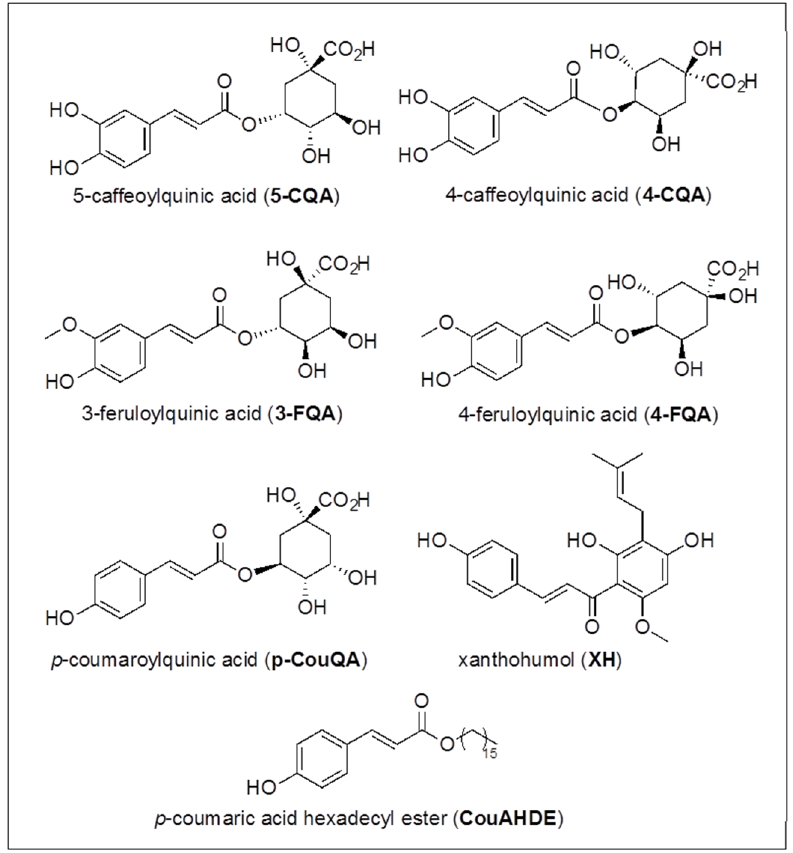
Scheme 4. Hydroxycinnamic acids derivatives structures